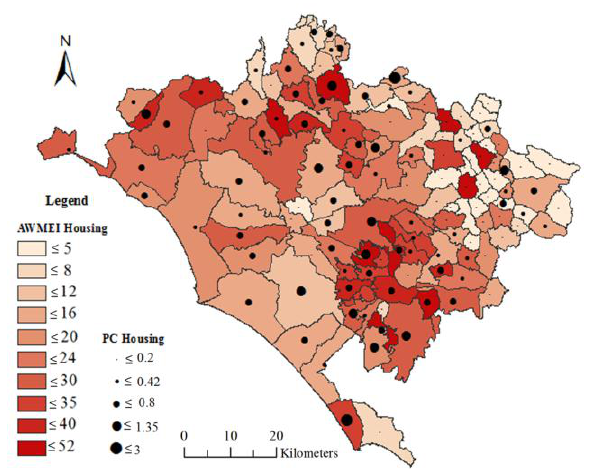
Figure 8. Housing AWMEI and PC at administrative level. High values of AWMEI mean growth compactness, while high values of PC mean more density of change = 72.4% and a standard error of 249.2. This test points the feasibility of using fragmentation metrics as estimator of population for a single date. However, applying the same methodology using the multi-temporal indices as independent variables to estimate the increase in the density of population, no significant relation was found. This seems to reflect that changes in housing land use and urban areas (first level) do not have a linear relation to the increase of the density of population. A partial explanation can be found in the lack of a more continuous series of data for these years. Figure 9 shows the evolution of population in the period studied. According to the statistics in the province of Rome (Iptsat, 2013), there was a continuous increase of population between 2001 and 2010 (Figure 9b), but the absolute increment value in the period studied (2006-2012) was very low, due to the punctual